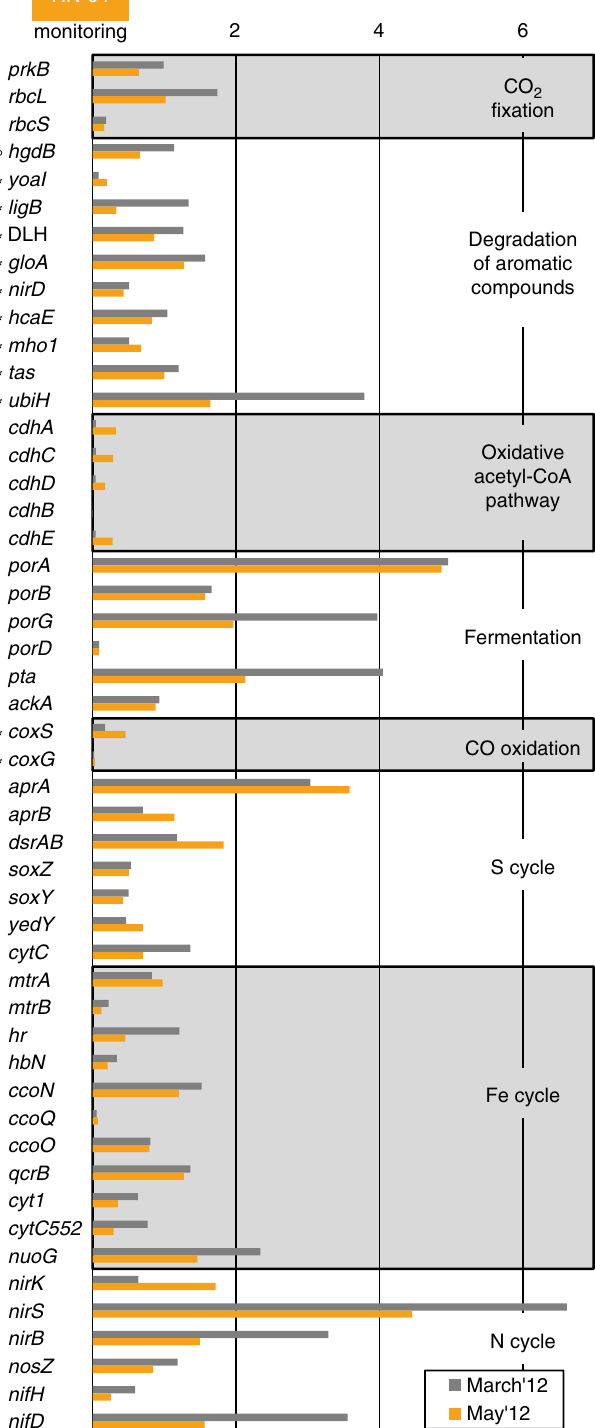
Fig. 6 Normalized counts of key biomarkers in groundwater from monitoring well HN-04 sampled in March and May 2012.